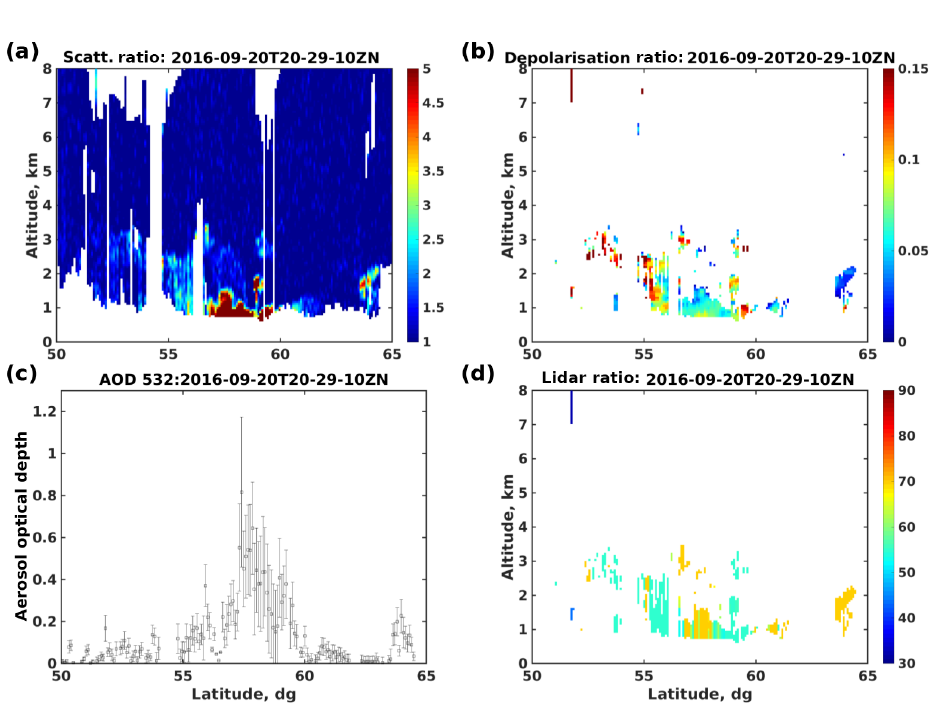
Figure 16. Same as Fig. 14 for 20 September